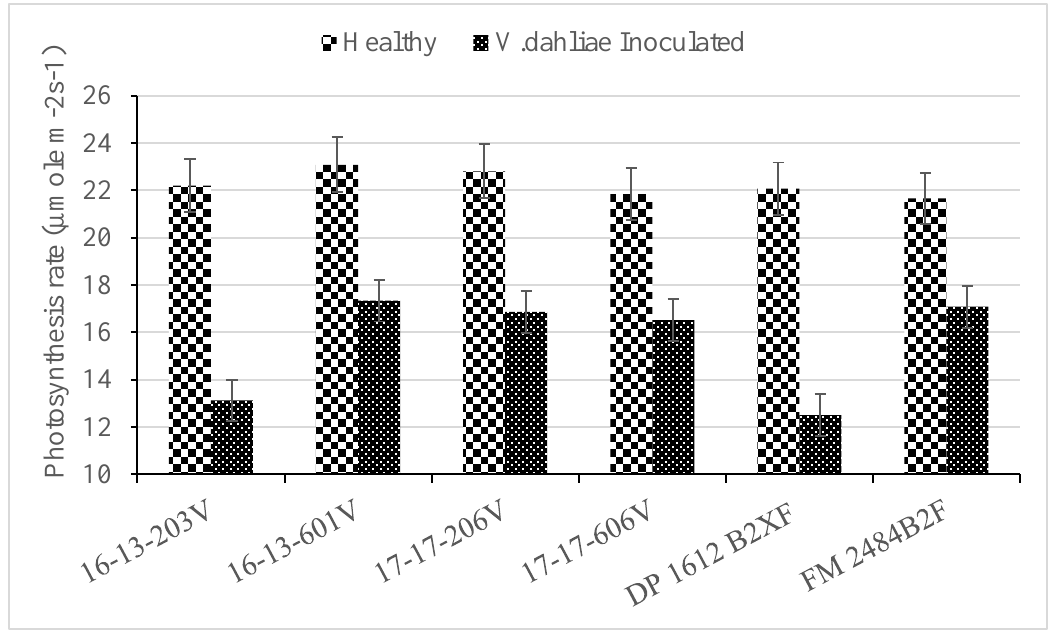
Figure 2. Impact of Verticillium wilt on photosynthesis rate of greenhouse-grown upland cotton breeding lines (16-13-203V, 16-13-601V, 17-17-206V, and 17-17-606V) and cultivars (DP 1612 B2XF and FM 2484B2F). The graph illustrates the average photosynthesis rate for 12 repeated measurements, 6 replications, and 3 tests for healthy and V. dahliae treated plants. Standard error bars are shown for each mean.